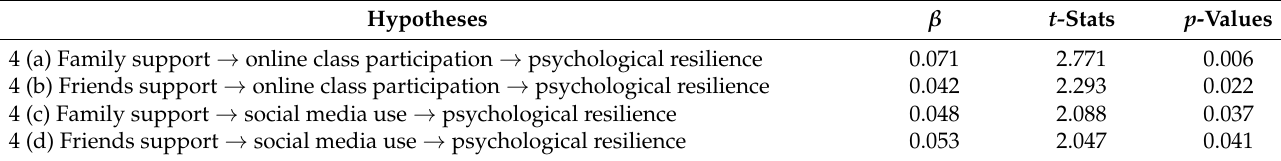
Table 9. Indirect paths specific relations.